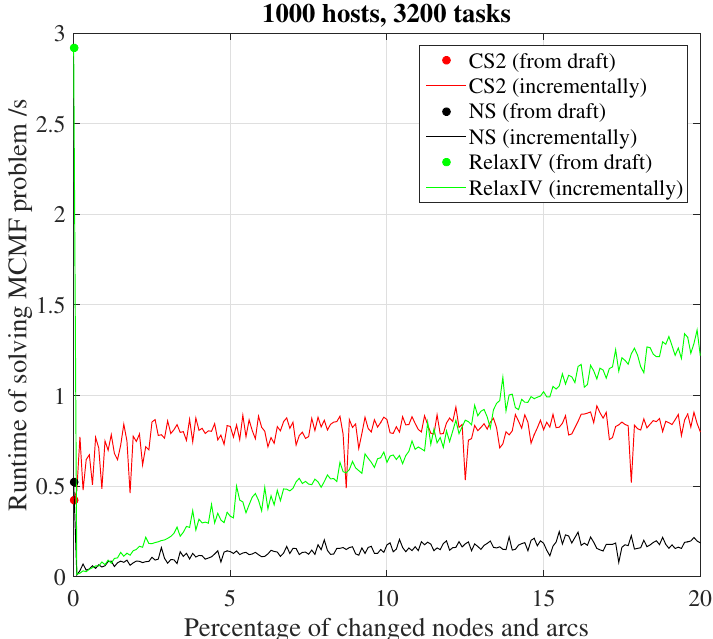
Figure 4. Runtime of different MCMF